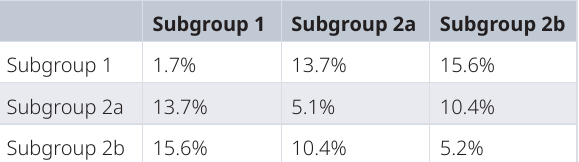
Table 3. Average pair-wise genetic distance within (on- diagonal) and among (off-diagonal) SLRV A2 subgroups characterized in this study.